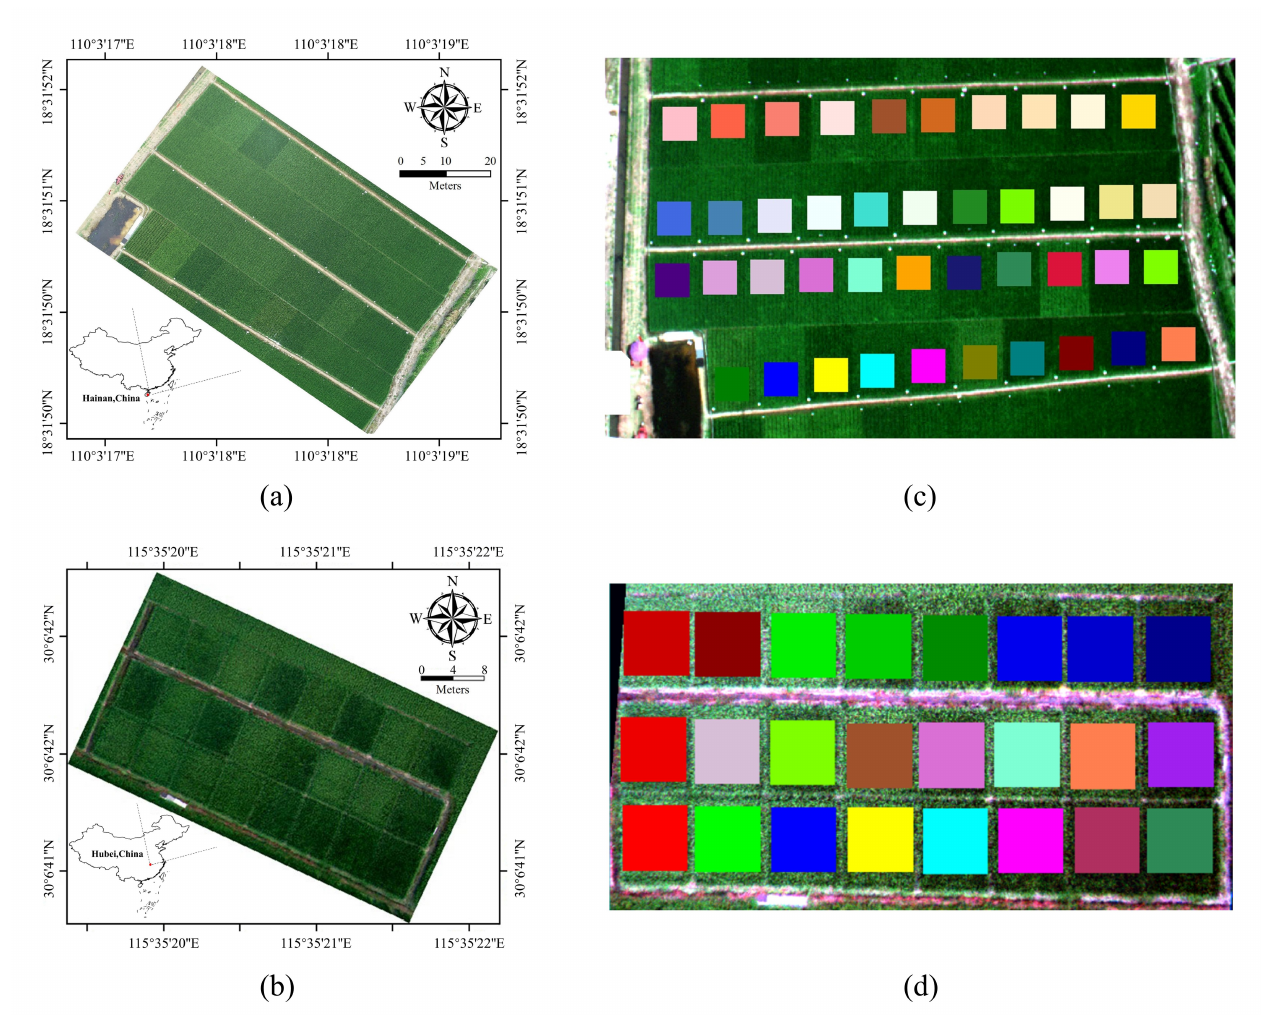
Figure 2. The location of the study site and the regions of interest in each plot. ( a , b ) Study Area 1 Lingshui and ( c , d ) Study Area 2